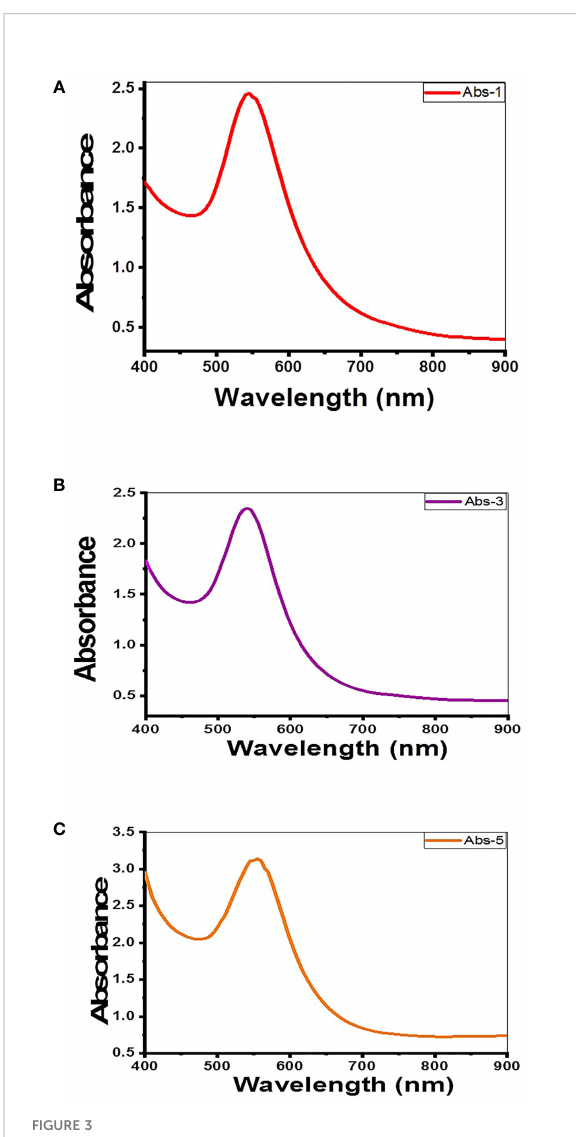
FIGURE 3 UV – visible spectrum of Au-NPs biosynthesized using extracts of macroalgae (A) C. myrica , (B) C. trinodis , and (C) C. prolifera